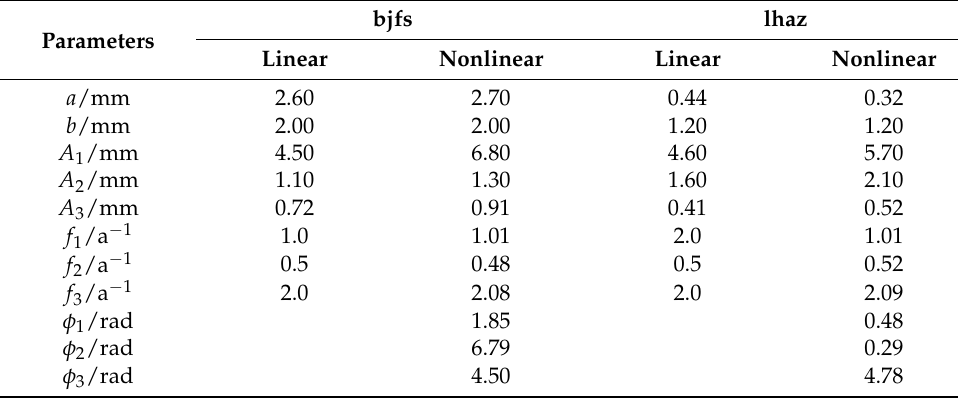
Table 3. The RMSE index of bjfs and lhaz CORS height